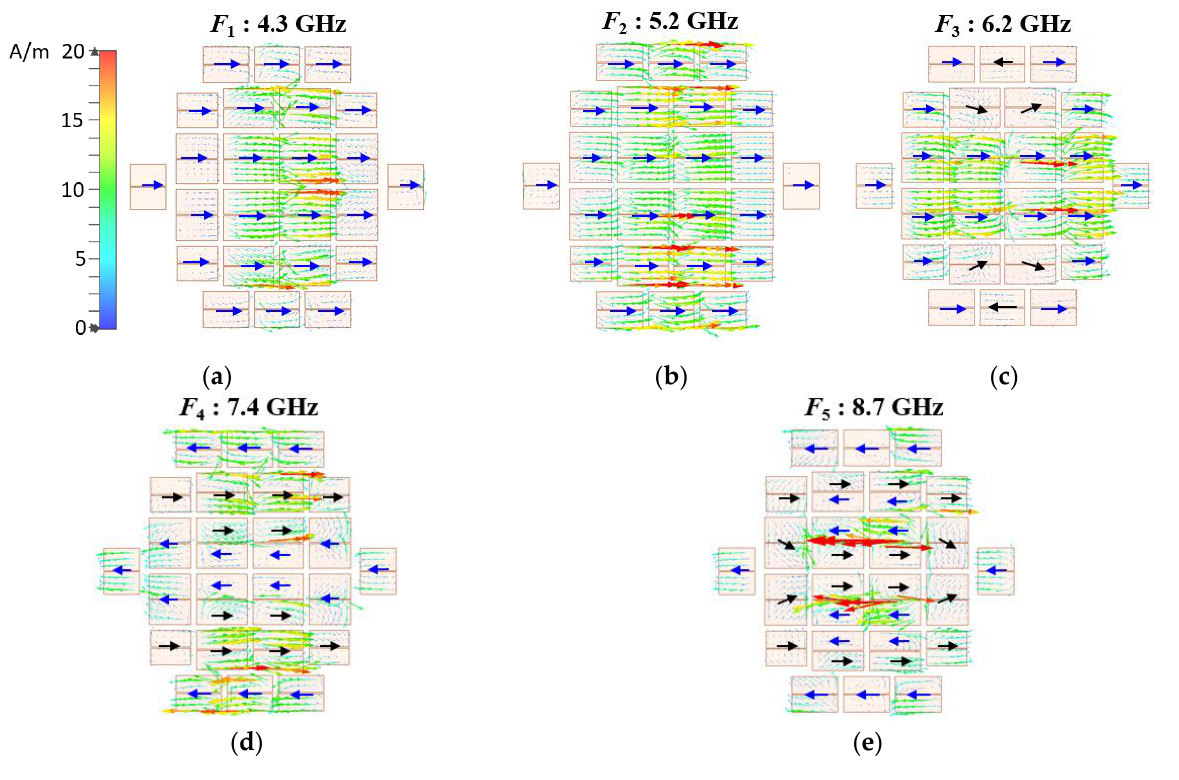
Figure 11. Simulated surface currents of the proposed antenna at resonant frequencies. ( a ) F 1 : 4.3 GHz, ( b ) F 2 : 5.2 GHz, ( c ) F 3 : 6.2 GHz, ( d ) F 4 : 7.4 GHz and ( e ) F 5 : 8.7 GHz